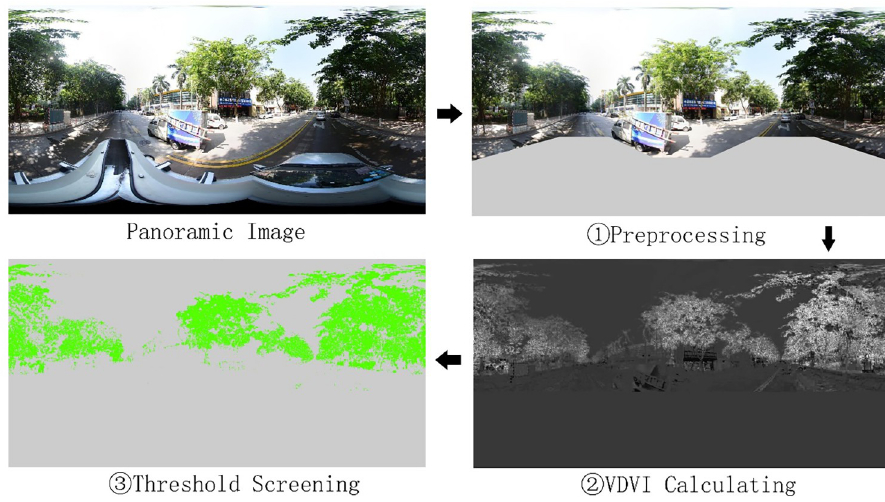
Fig 1. Vegetation extraction in